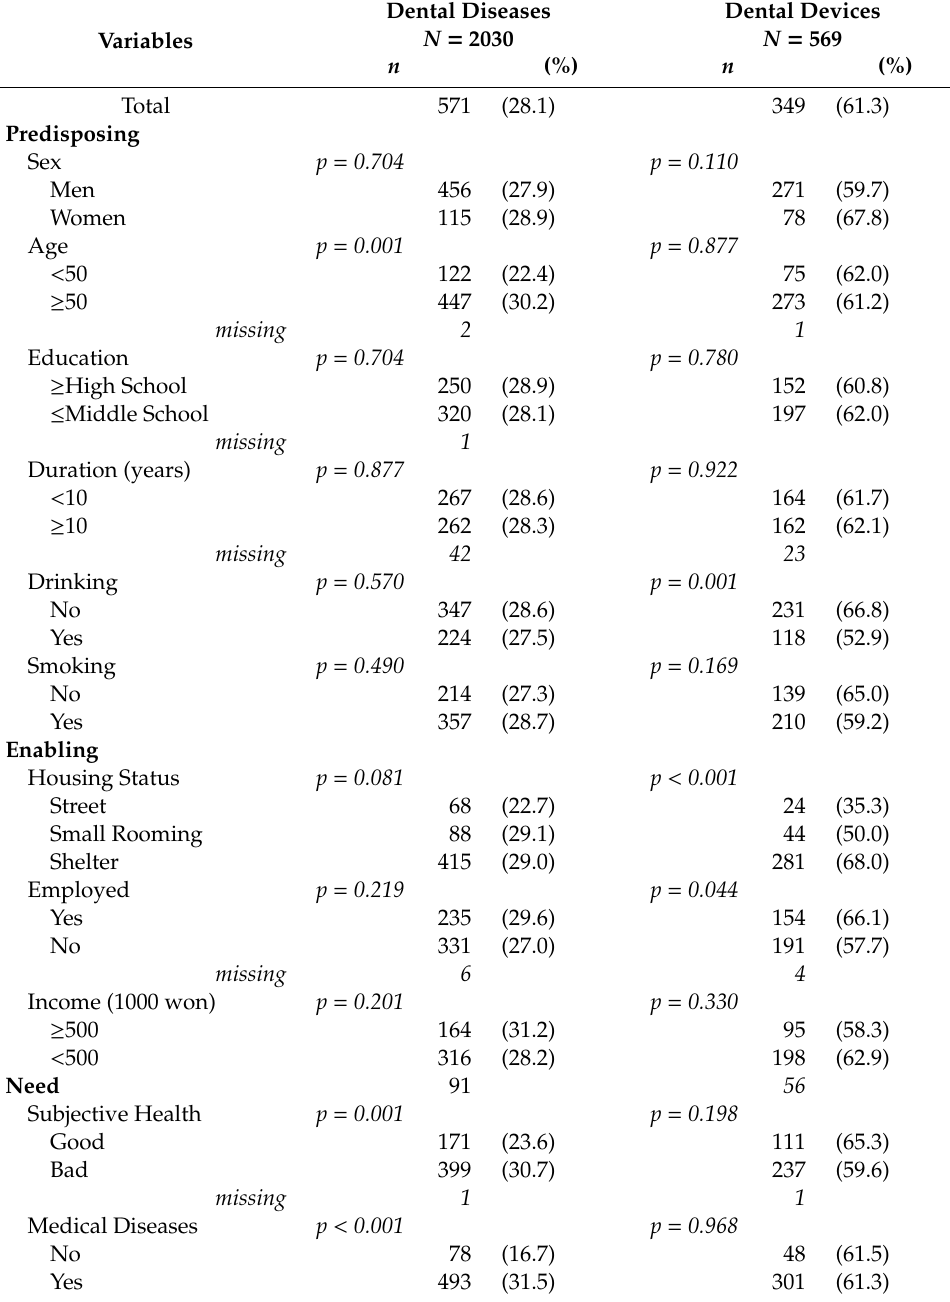
Table 2. The dental diseases and the utilization of dental services by three domains of Gelberg–Andersen behavioral model in homeless people, S.